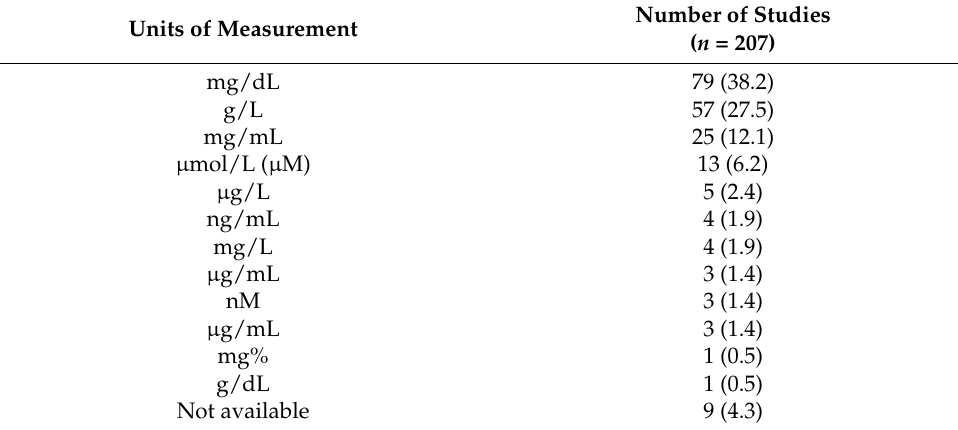
Table 2. Summary of the units of measurement of AAT